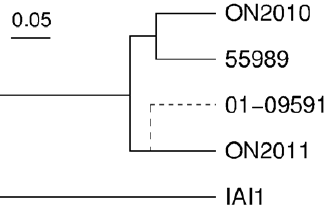
Figure 4. Optical map similarity cluster of the E.coli O104:H4 strains. De novo whole genome optical maps from the ON2010 and ON2011 strains were generated using the Argus TM optical mapping system with the Ncol restriction enzyme. An in silico genomic map of the 55989 strain was generated in MapSolver TM by applying the Ncol restriction pattern. A close relationship between LB226692 and 01- 09591 was reported by Mellmann et al. 2011 using the same restriction enzyme, and the 01-09591 branch is added as